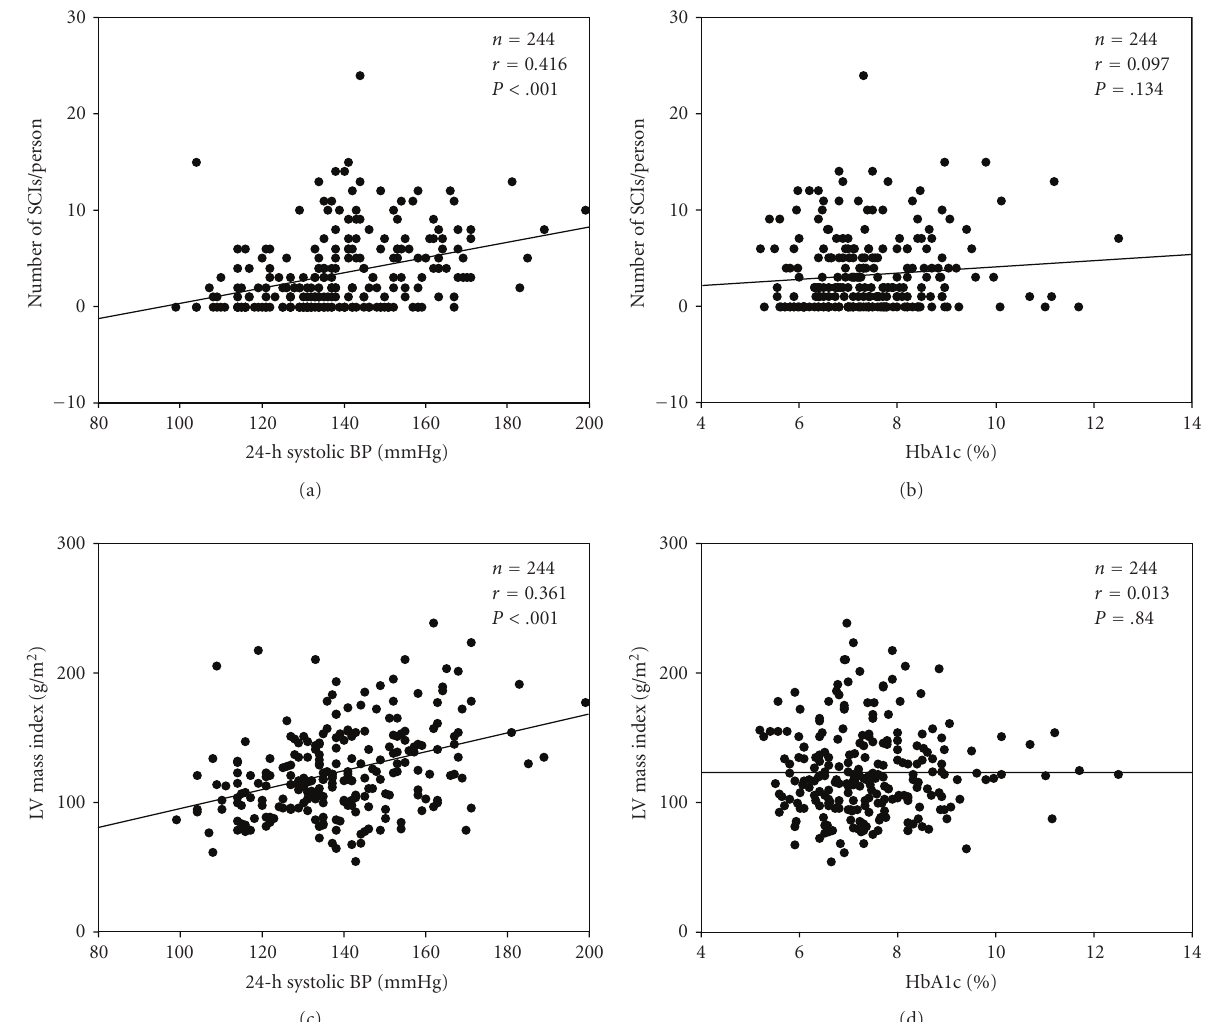
Figure 1: (a) and (b) represent 24-hour systolic blood pressure (BP), glycosylated hemoglobin (HbA1c), and number of silent cerebral infarcts (SCIs). (c) and (d) represent 24-hour systolic BP, HbA1c, and left ventricular (LV) mass index (adopted from